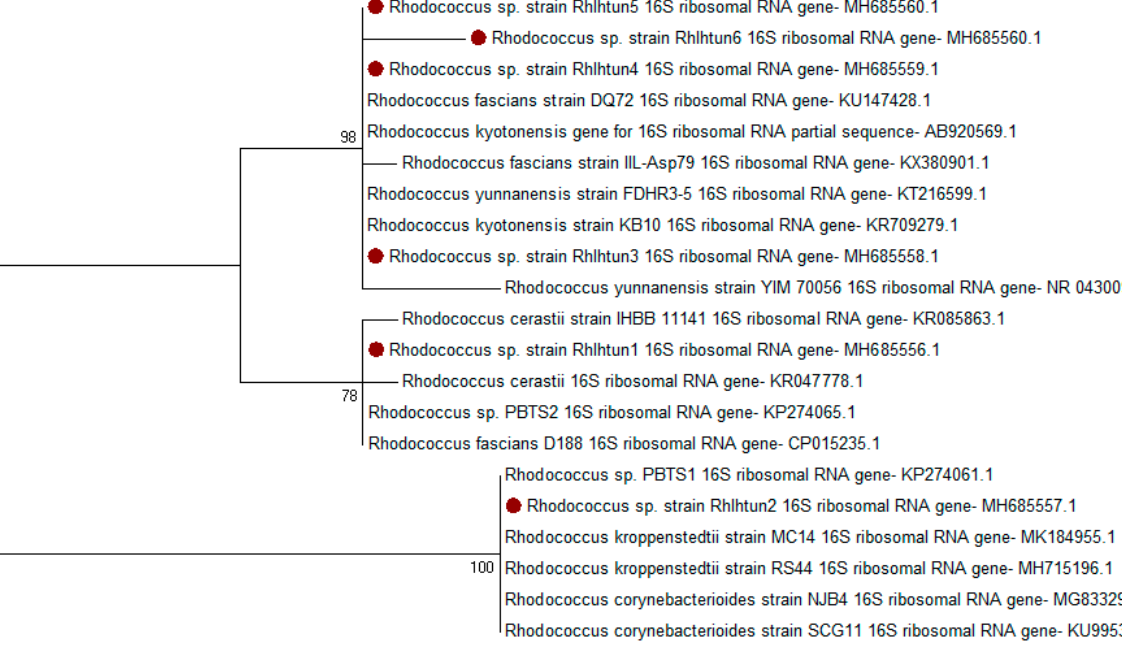
Table 1. Symptom development on Iresine herbstii ‘Aureo-Reticulata’ in response to inoculation with six isolates of Rhodococcus spp.